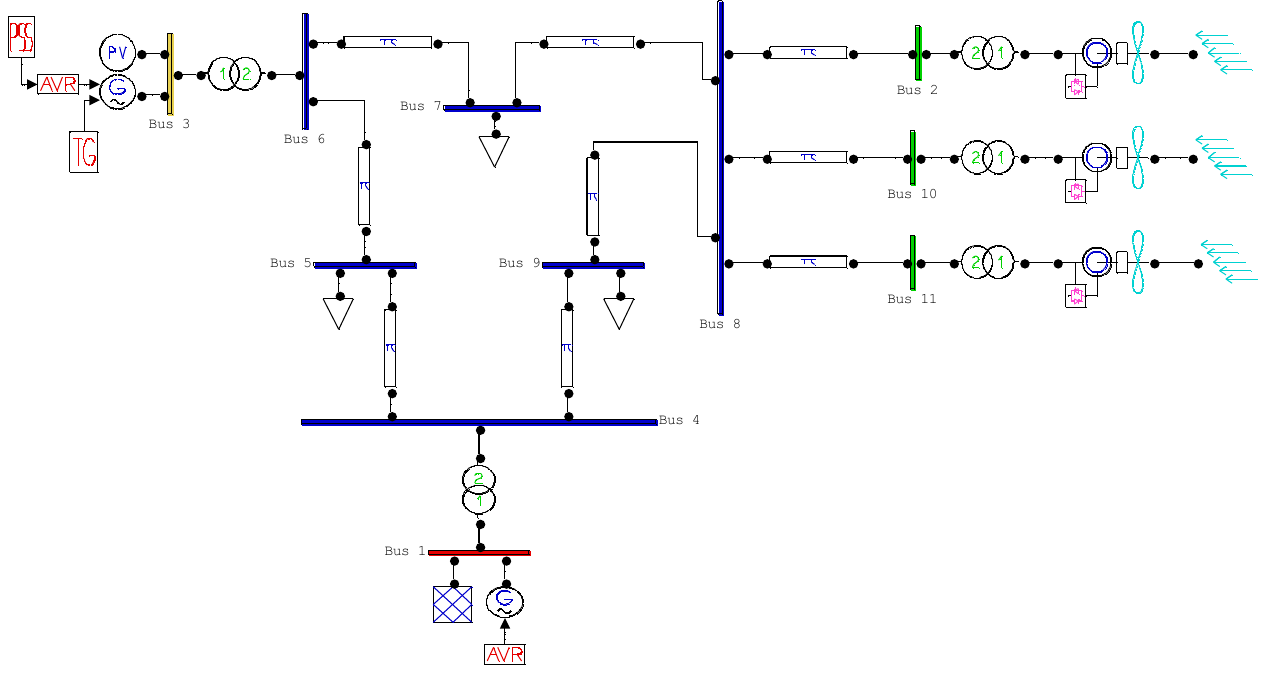
Figure A1. The structure of the nine bus system.